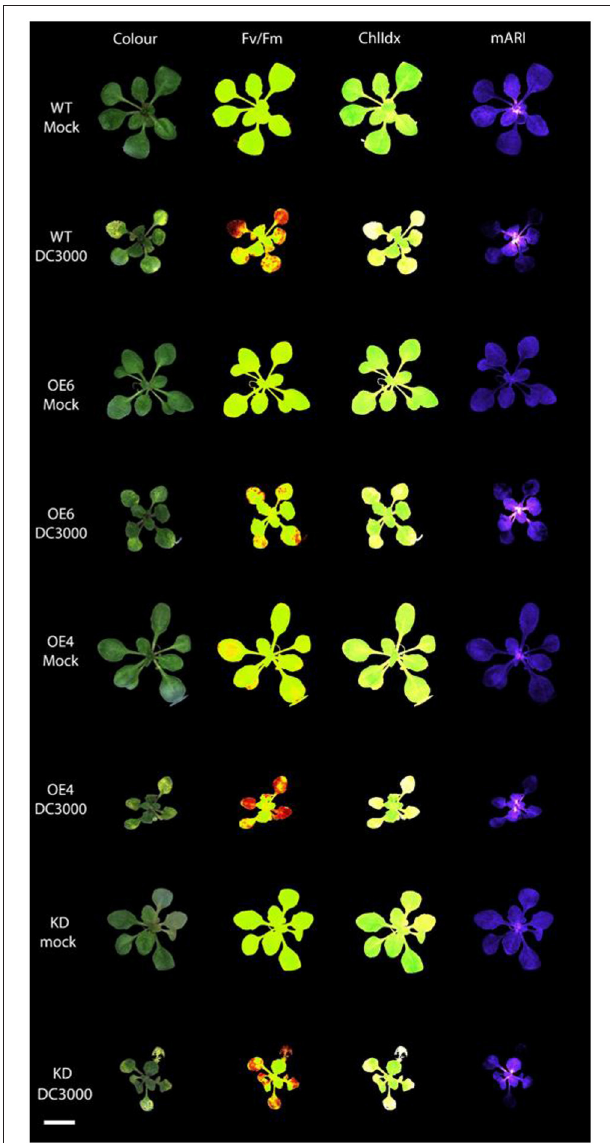
FIGURE 3 | Multispectral images of Arabidopsis rosettes at 3 days after mock treatment and Pst DC3000 inoculation. The different images represent the RGB Color image; Fv/Fm: efficiency of photosystem II; ChlIdx: chlorophyll index, a measure for chlorophyll; mARI: modified anthocyanin reflectance index, a measure for the amount of anthocyanin content. Scale bar represents 1cm.